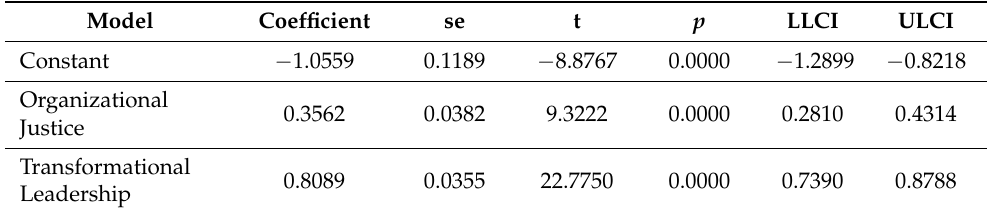
Table 8. Coefficients of Regression (path-b and